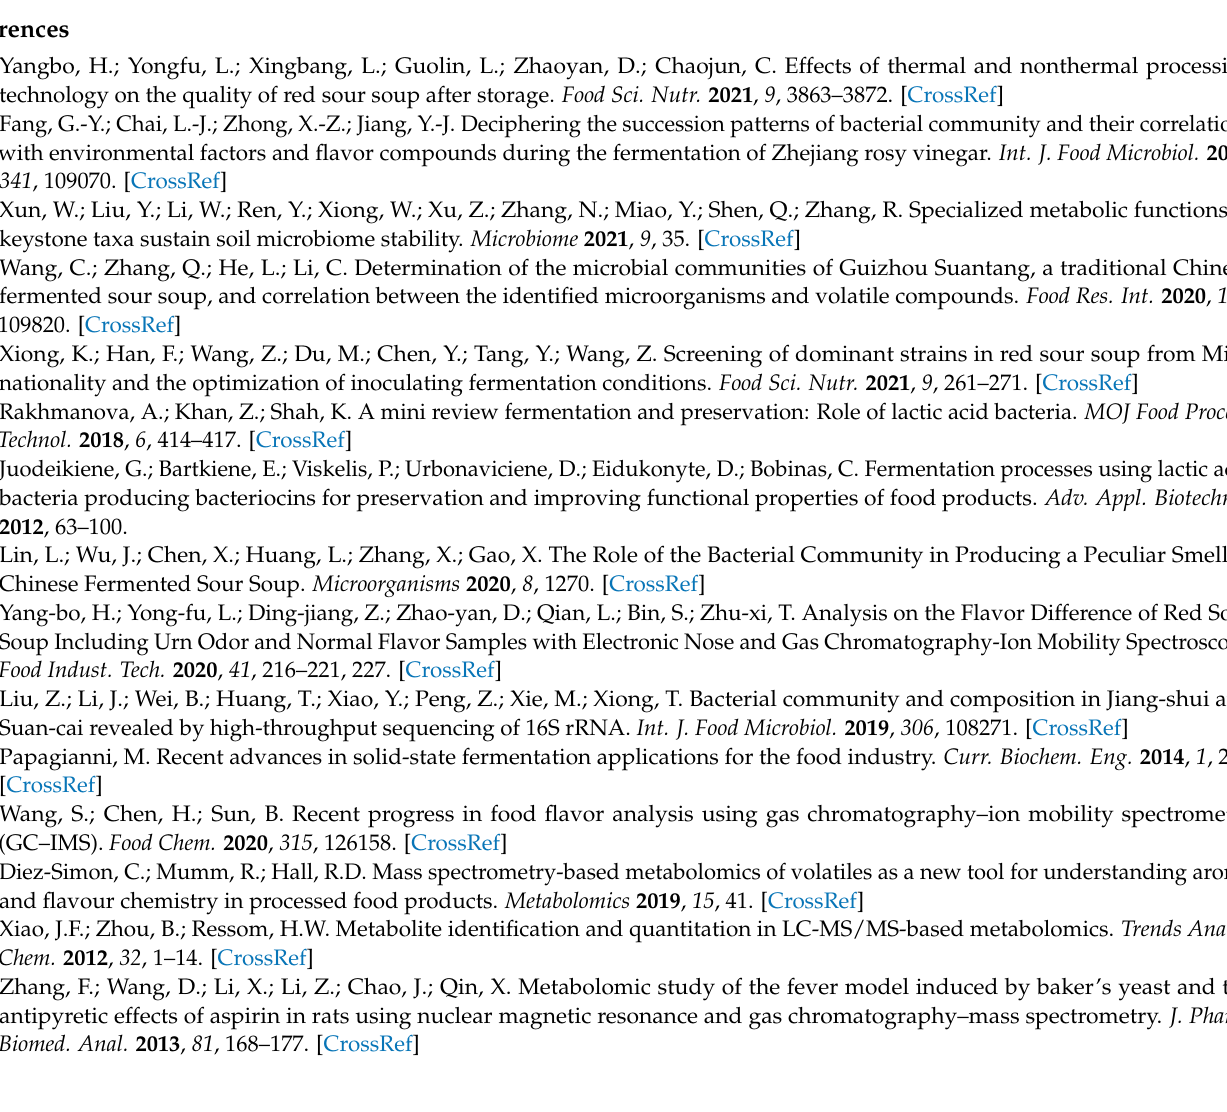
Effect Size (LEfSe) analysis showing pre-dominant bacterial strain in each treatment group, Figure S5: Venn diagram showing common and unique metabolites in the control and different treatment samples, Figure S6: OPLS-DA plots showing variations in metabolites in different treatment groups, Figure S7: Differential metabolite screening bar charts, Figure S8: KEGG enrichment statistics and Figure S9: Heat map showing Spearman correlation of top 20 differential metabolites and dominant bacterial species, Table S1: Sequencing data